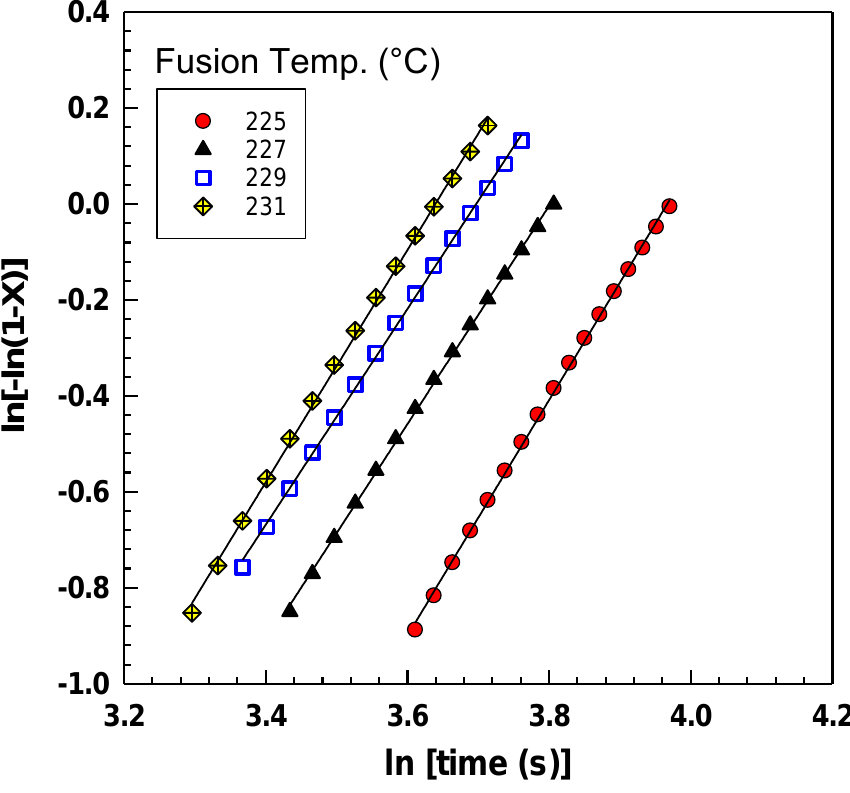
Figure 5. Avrami plot of ln [ − ln( 1 − X(t))] versus ln(t) at different fusion temperatures. Table 2. Avrami parameters of nonisothermal crystallization of PA6 at different fusion temperatures. Fusion Temp. ( ◦